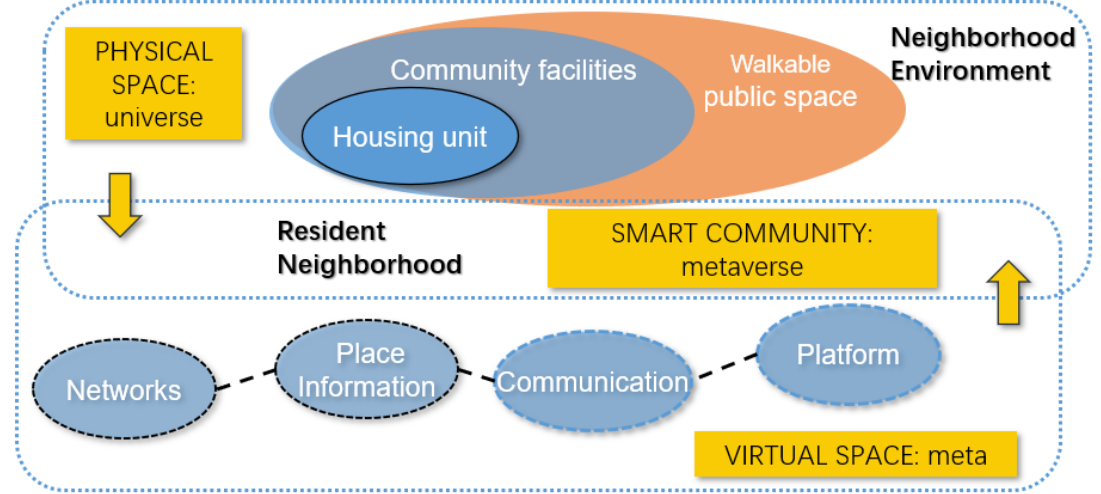
Figure 4. Smart Community Based on Residential and Neighborhood Environment.